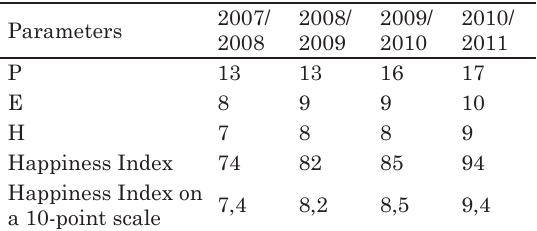
Table 3. The answers of one respondent to the questions related to the formula for happiness